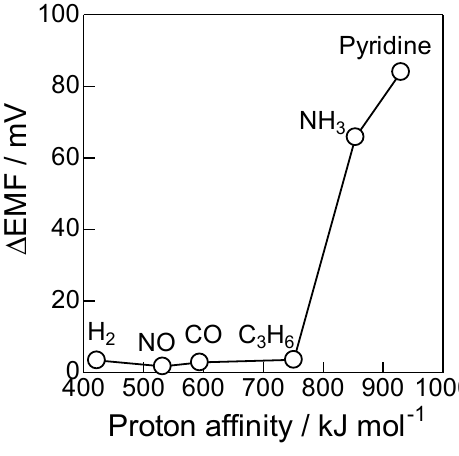
Figure 6.  EMF of Bi